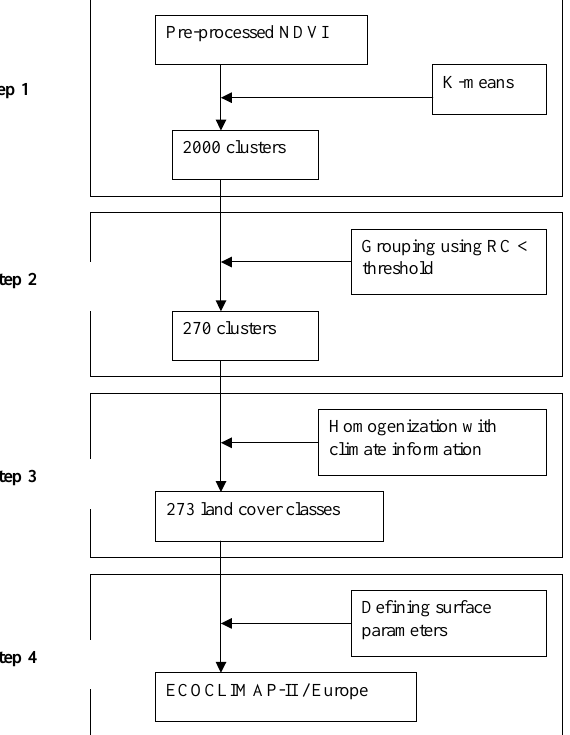
Fig. 4. Schematics of the different steps for the construction of ECOCLIMAP land cover